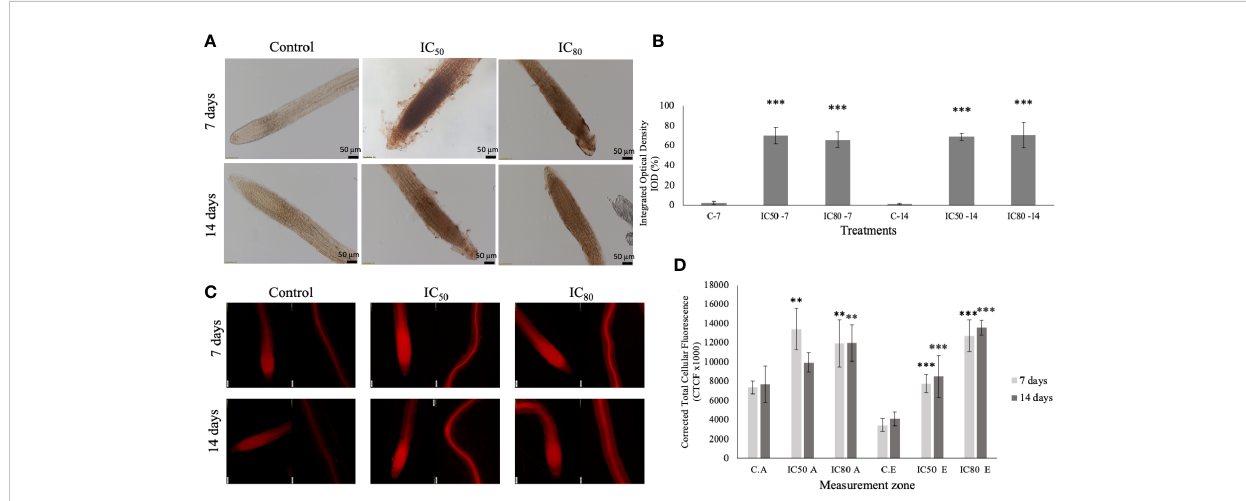
FIGURE 8 (A) In situ determination of H 2 O 2 in A . thaliana seedlings control (C) and treated with the IC 50 and IC 80 of TC for 7 and 14 days. Scale: 50 m M; (B) quanti fi cation of the integrated optical density (IOD) expressed as a percentage of the root area stained with DAB. C-7 (control 7 days), IC 50 -7 (IC 50 of TC after 7 days), IC 80 -7 (IC 80 of TC after 7 days), C-14 (control 14 days), IC 50 -14 (IC 50 of TC after 14 days), IC 80 -14 (IC 80 of TC after 14 days). Asterisks indicate signi fi cant differences compared to the control: *** ( p ≤ 0.001); (C) in situ determination of O 2 − in A . thaliana seedlings treated with IC 50 and IC 80 TC for 7 and 14 days in apex and root elongation zones. Scale: 50 m m; (D) quanti fi cation of corrected total cellular fl uorescence (CTCF) of roots stained with DHE. C.A (control apex), IC 50 A (IC 50 apex), IC 80 A (IC 80 apex), C.E (control elongation zone), IC 50 E (IC 50 elongation zone), IC 80 E (IC 80 elongation zone). Asterisks indicate signi fi cant differences compared to the control: ** ( p ≤ 0.01), *** ( p ≤ 0.001). Bars indicate standard